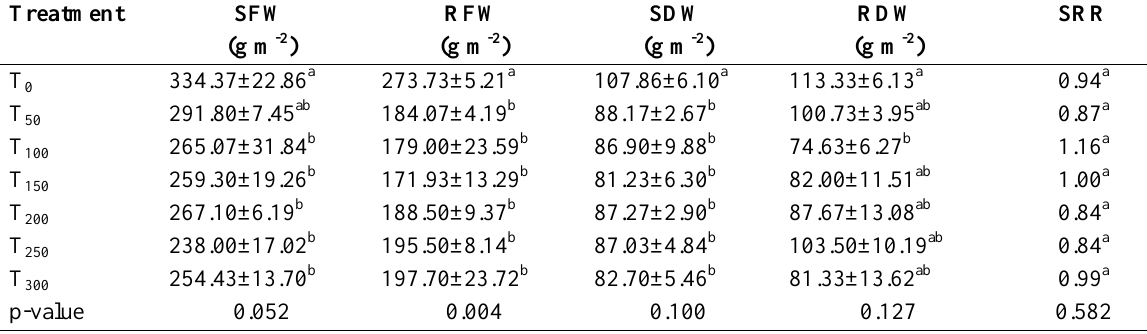
Table 1: Yield of C. aciculatus grown in soils contaminated with different concentrations of Ni.